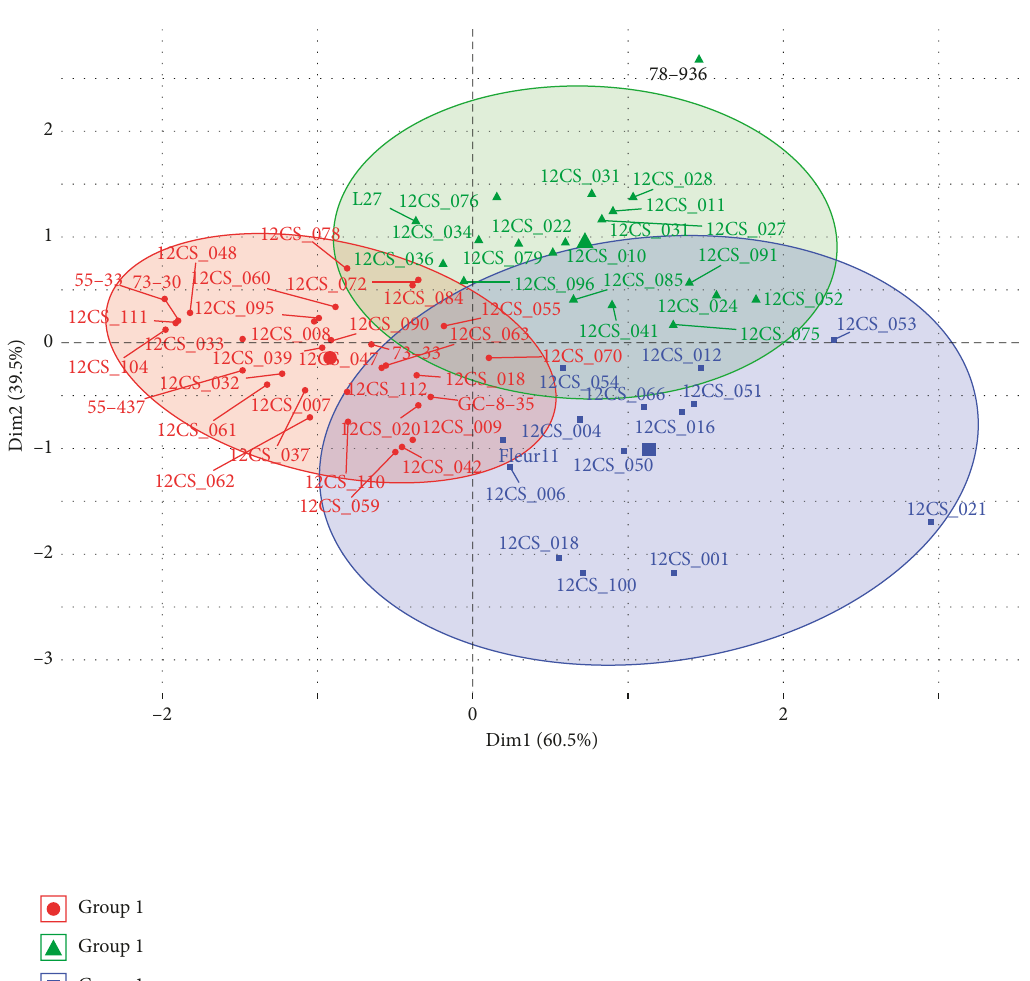
Table 5: Description of each cluster based on incidence, aflatoxin concentration levels, and paragon and singular genotype per cluster. Cluster 1 Cluster 2 Cluster 3